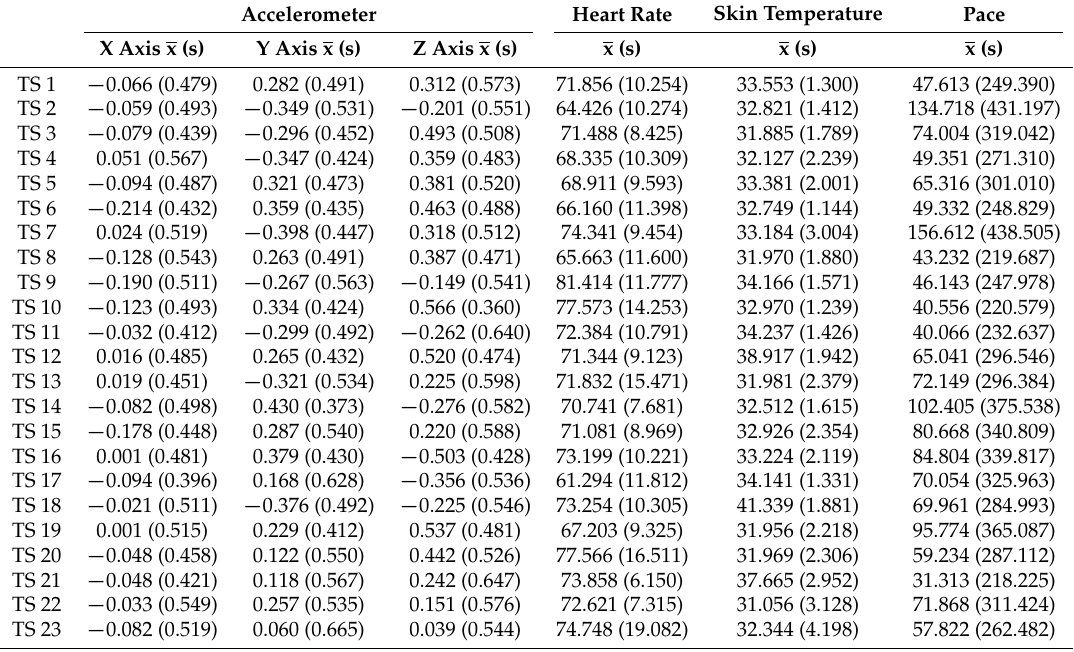
Table A2. Normal conditions dataset. Part